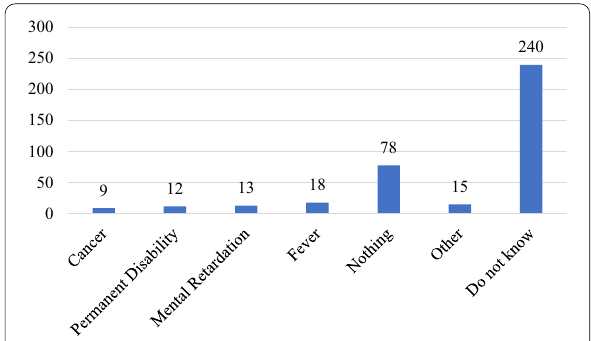
Fig. 4 Complication of migraine as perceived by the population of the study